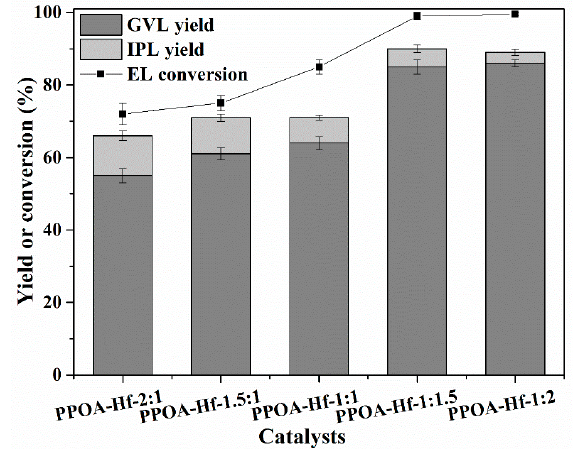
Figure 6. Catalytic results of PPOA–Hf- x with various PPOA/Hf molar ratios in the conversion of ethyl levulinate (EL) to GVL. Reaction conditions: EL, 1 mmol; catalyst, 72 mg; 2-propanol, 5 mL; T, 160 °C; and t , 6 h.